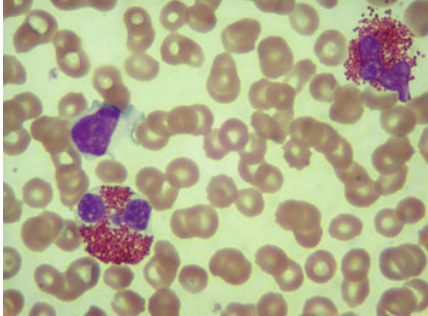
Figure 1: This computer tomography image of the abdomen and pelvis with oral and intravenous contrast shows multiple areas of small bowel wall thickening (arrowheads). Also notice the perihe- patic accumulation of ascitic fluid (arrow).